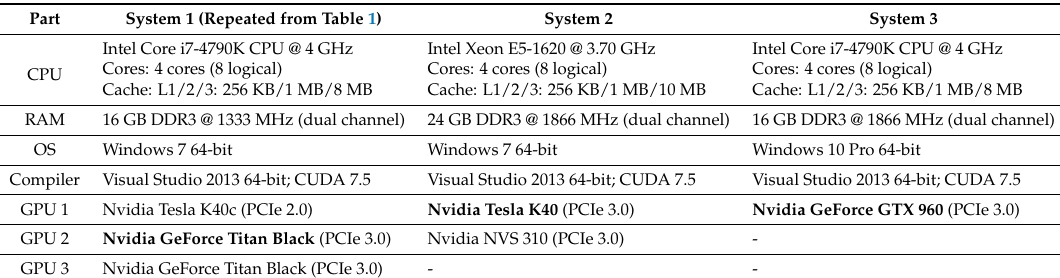
Table 5. Details of the systems containing different GPUs (the specific GPU employed on each system is shown in boldface).